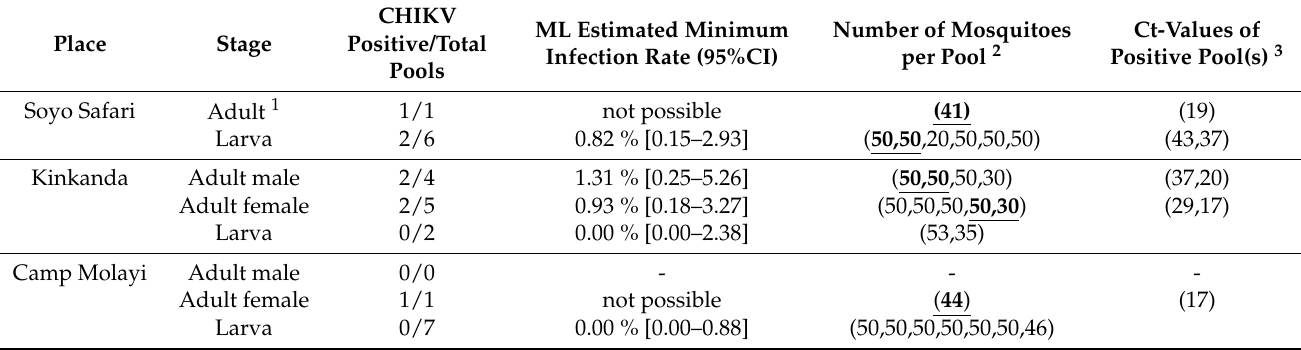
ML = Maximum likelihood. 1 Adults in Soyo were not differentiated by sex due to difficult fieldwork conditions at the start; 2 Pools in bold and underlined indicate CHIKV-positive pools. Pools were only considered to be CHIKV positive if they were positive after two independent extractions and PCR runs. 3 The values represent averages of the obtained